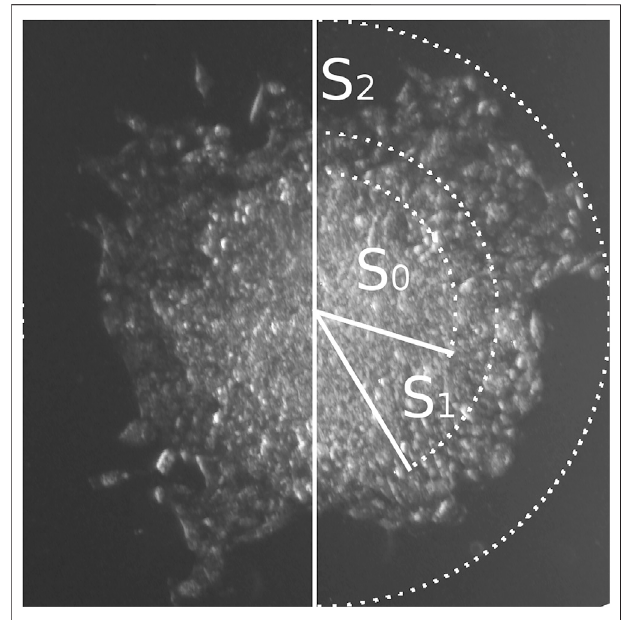
FIGURE 3 | Three zones of cellular migration from MCTS. Representative image ofthe MCTS on plastic at the time point 24 h with zonal segmentation to S0, S1, and S2 areas characterized by different optical density of cell